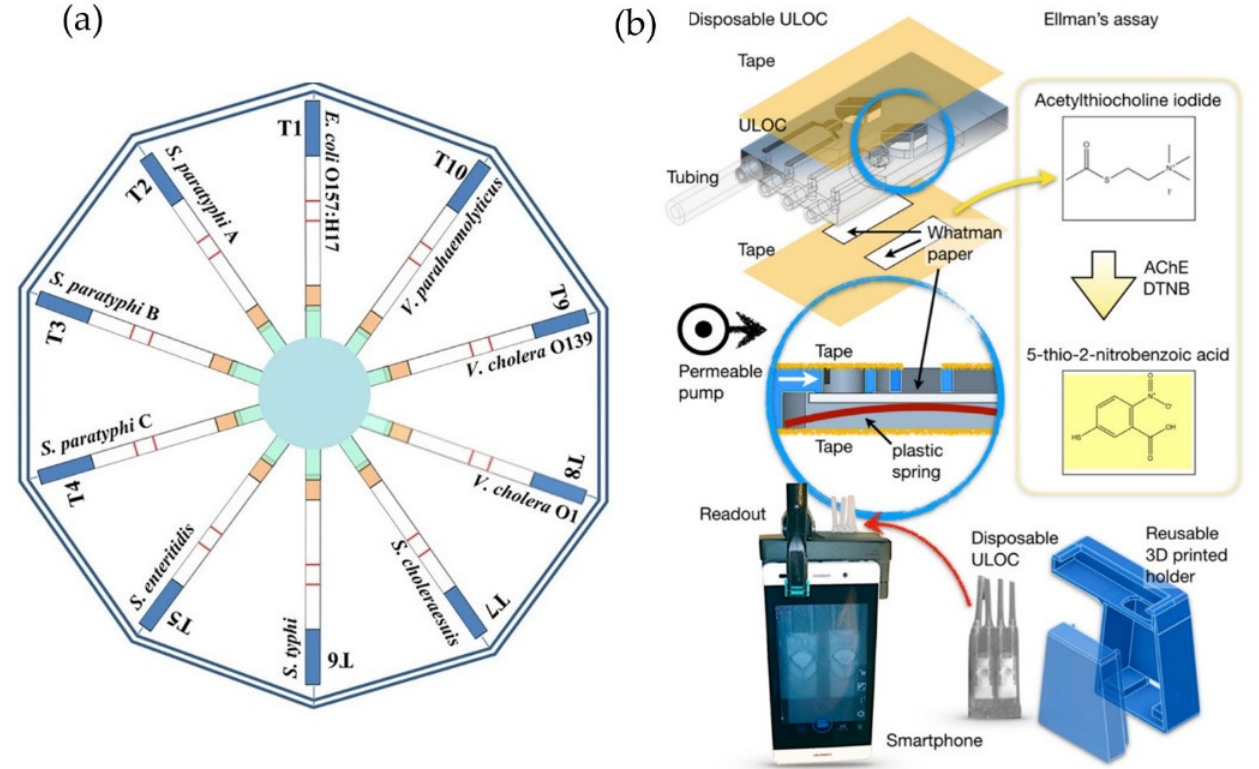
Figure 1. Examples of hybrid paper-based optical food analyzers: ( a ) a disc containing 10 different LFA assays for foodborne pathogen detection. Reproduced with permission from [18] Scientific reports, Copyright (2016), under CC BY 4.0; ( b ) a hybrid paper-LOC device provides semiquantitative carbofuran screening using a smartphone as a detector. Reproduced with permission from [19] Sensors, Copyright (2019), under CC BY 4.0.